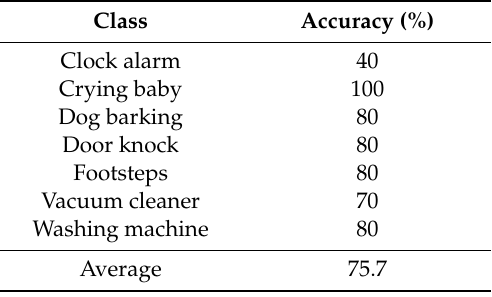
Table 1. Classification accuracy of the test